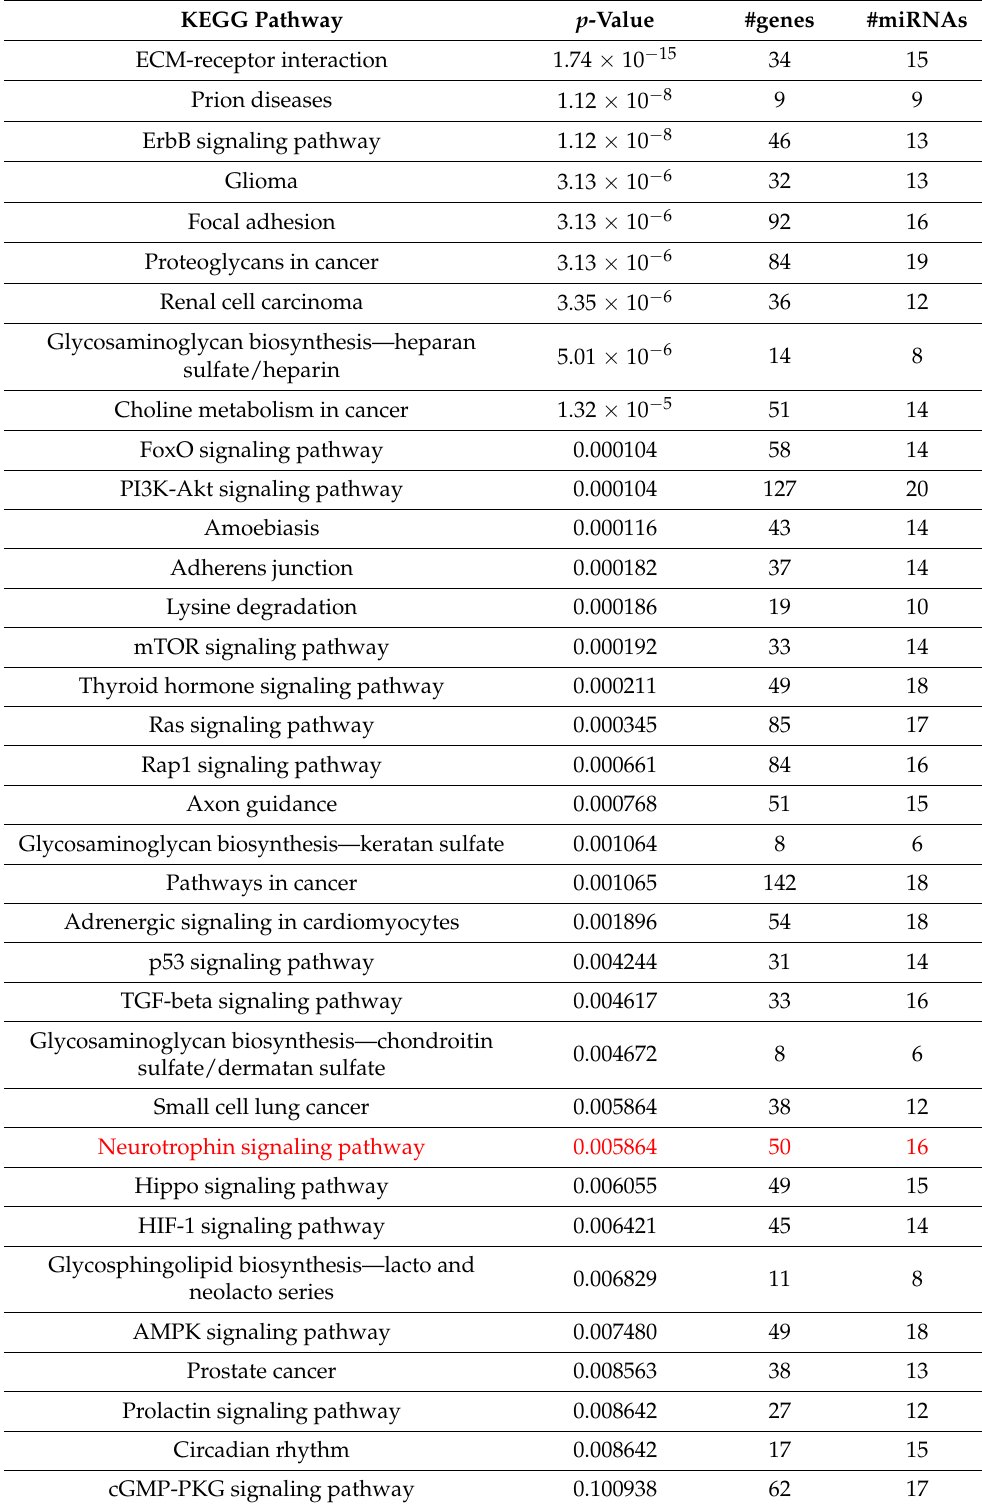
Table 3. DIANA-microT-CDS pathway analysis in response to rhNGF. KEGG pathways identified by considering significant dysregulated miRNAs (n = 21), as detected by DIANA-microT-CDS (predicted) analysis. The pathway analyzed in this study is highlighted in